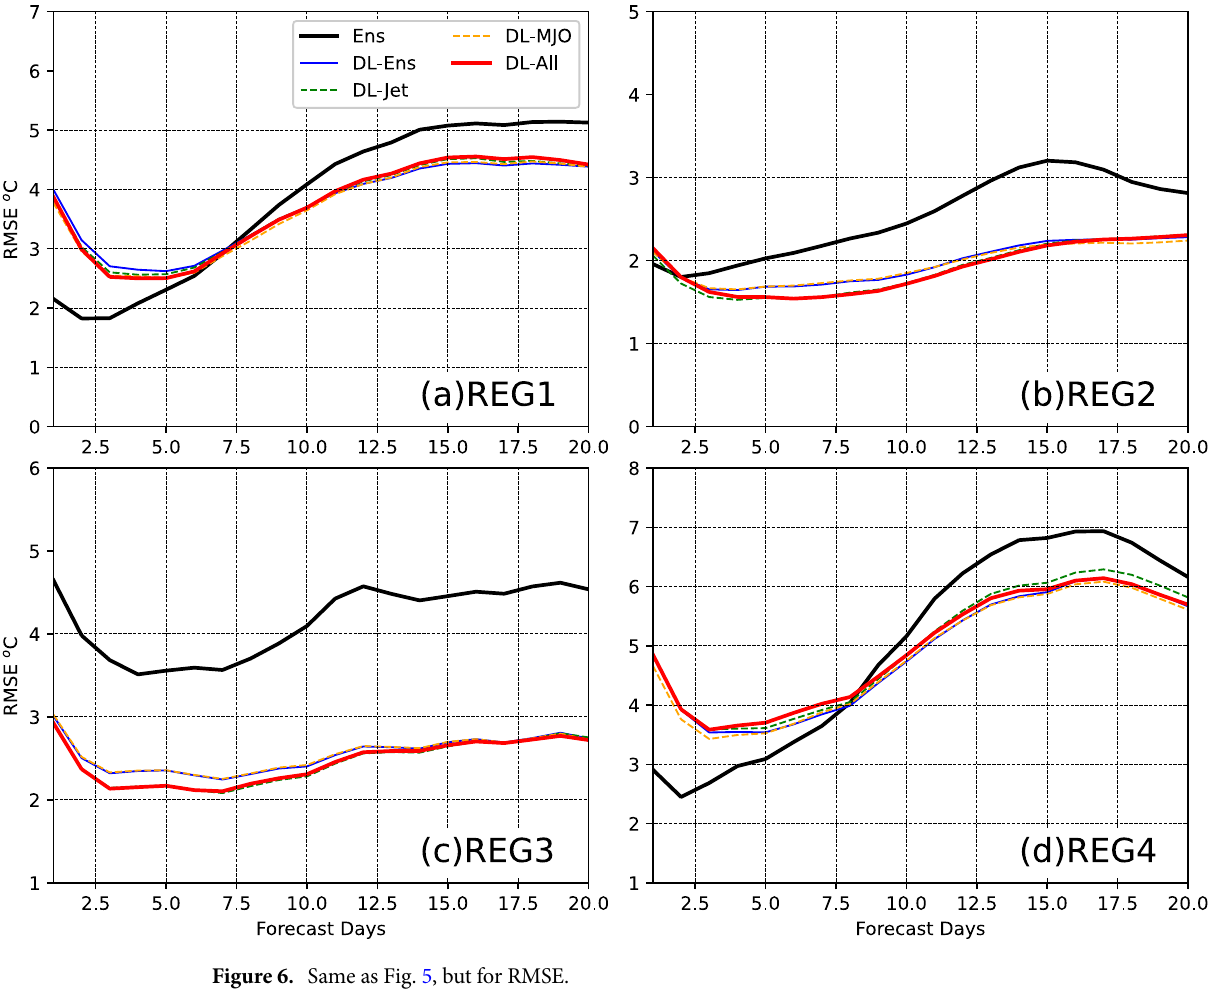
Figure 6. Same as Fig. 5, but for